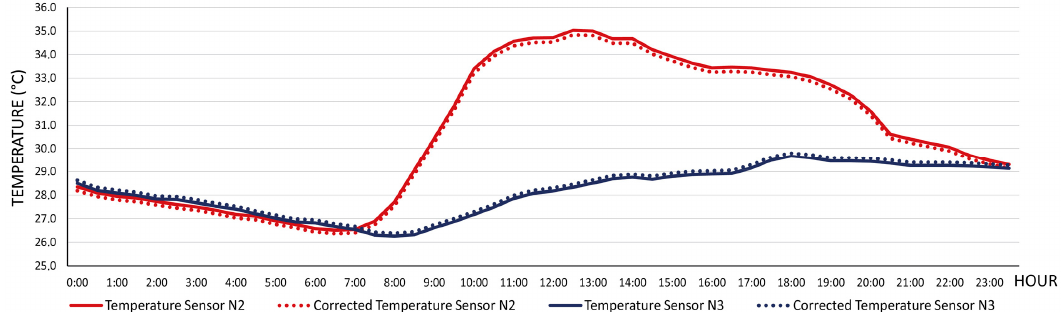
Figure 19. Flow diagram showing the impact of the change of materials used in an area of each of the points of the wall.